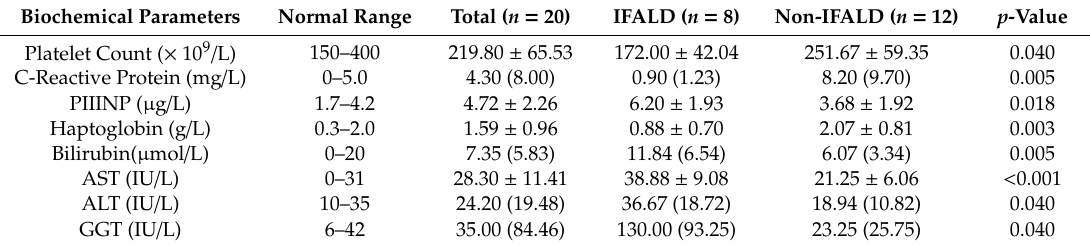
Table 3. Comparisons of non-invasive biochemical parameters between adult participants with IF diagnosed with IFALD or no IFALD by radiological examinations (mean ± SD and median (range)).